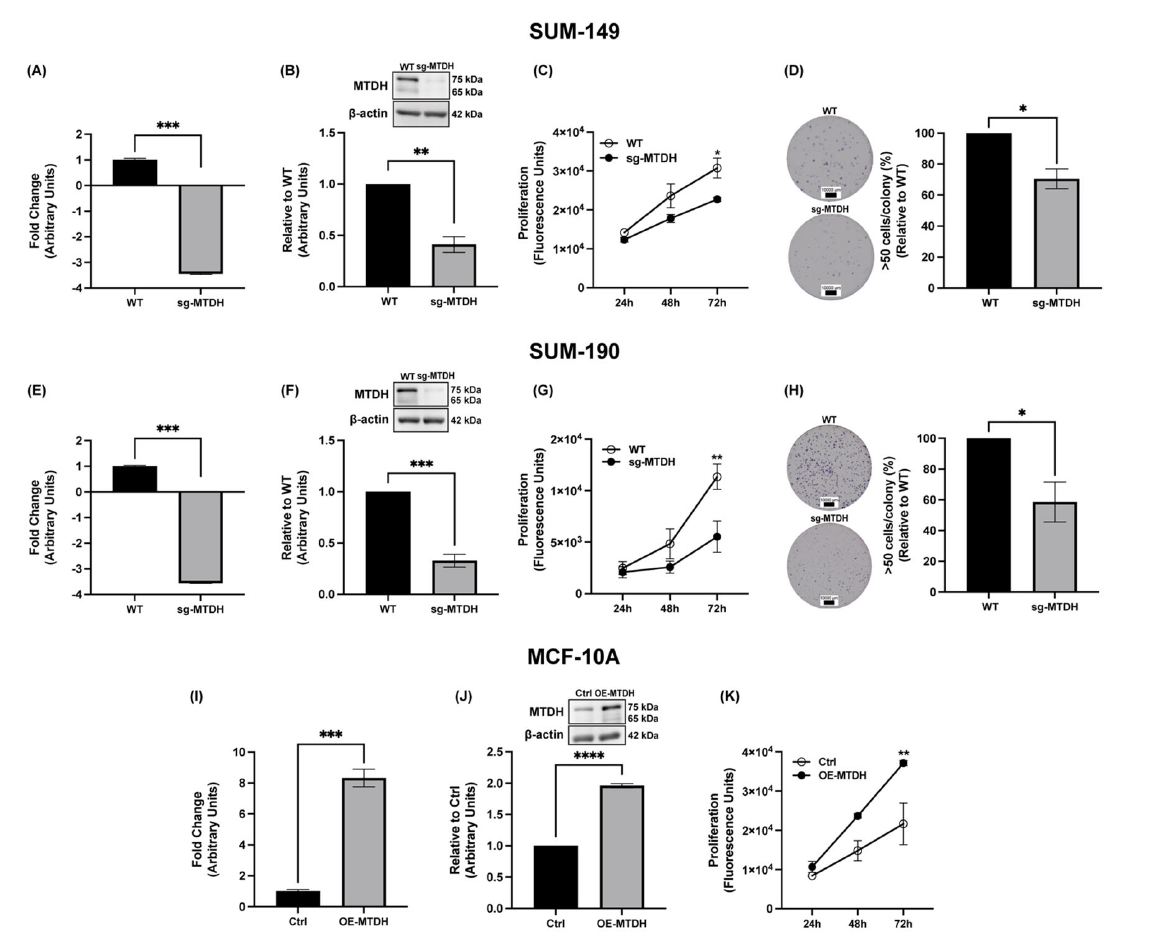
Figure 2. The proliferation and colony formation capacity of IBC cells was suppressed after MTDH knockout. ( A , B ) MTDH qPCR, immunoblot, and densitometry analysis of MTDH in wild-type (WT) SUM-149 cells after knockout of the MTDH gene (sg-MTDH) using CRISPR/Cas9. ( C ) Proliferation of SUM-149 WT and sg-MTDH cells. ( D ) Clonogenic capacity of SUM-149 WT and sg-MTDH cells. ( E , F ) MTDH qPCR, immunoblot, and densitometry analysis of MTDH in SUM-190 WT and sg-MTDH cells. ( G ) Proliferation of SUM-190 WT and sg-MTDH cells. ( H ) Clonogenic capacity of SUM-190 WT and sg-MTDH cells. ( I , J ) MTDH qPCR, immunoblot, and densitometry analysis of MTDH in MCF-10A cells after transduction with a control (Ctrl) vector or MTDH cDNA (OE-MTDH). ( K ) Proliferation of MCF ‐ 10A Ctrl and OE ‐ MTDH cells. MTDH qPCRs were performed using HPRT and RPL13A as reference genes, and changes in gene expression were calculated using the 2 ‐ΔΔ Ct method (*** p < 0.001). Immunoblots were performed with β -actin used as loading control and analyzed with Student’s t -test (** p < 0.01, *** p < 0.001 and **** p < 0.0001). Cell proliferation was tested for 24, 48, and 72 h and analyzed with two-way ANOVA with Bonferroni’s multiple comparison test; * p < 0.05, ** p < 0.01. SUM-149 and SUM-190, were incubated for 10 and 14 days, respectively. The colonies were stained with crystal violet, and the relative number of colonies with >50 cells were plotted. A montage of images from each well was obtained using the Cytation 10 Confocal Imaging Reader; scale bar = 10,000 µ m. A Student’s t -test was performed; * p < 0.05. Results are shown as Mean ± SEM. The experiments were carried out at least three times.